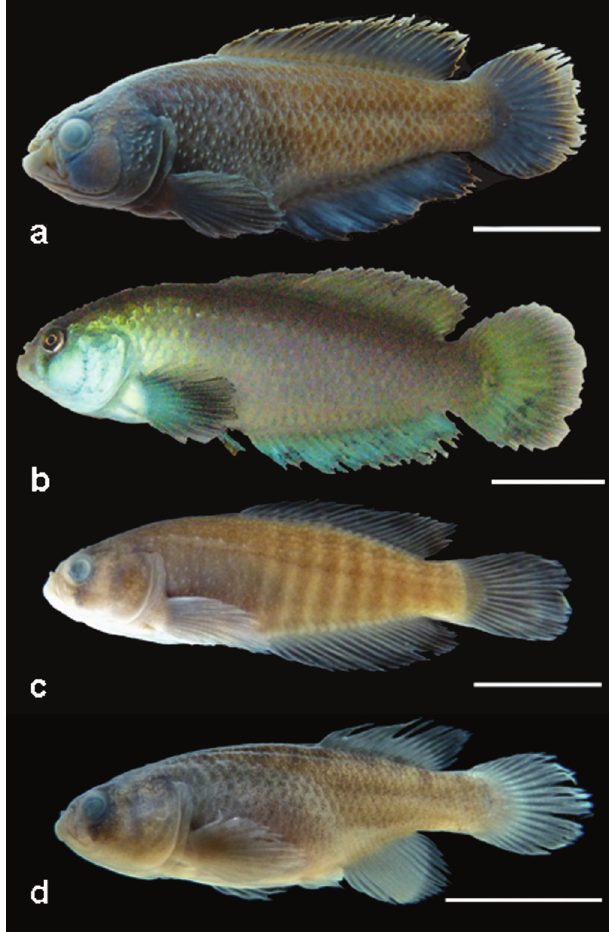
Fig. 1. a. Holotype of Austrolebias quirogai (ZVC-P 9758, 36.8 mm SL); b. Live male, paratype, from type locality (ZVC-P 8725, 39.8 mm SL); c. male, paratype (ZVC-P 8742, 31.2 mm SL) showing rare pigmentation pattern. d. Female, paratype, from type locality (ZVC-P 8725, 27.8 mm SL). Scale bars = 10